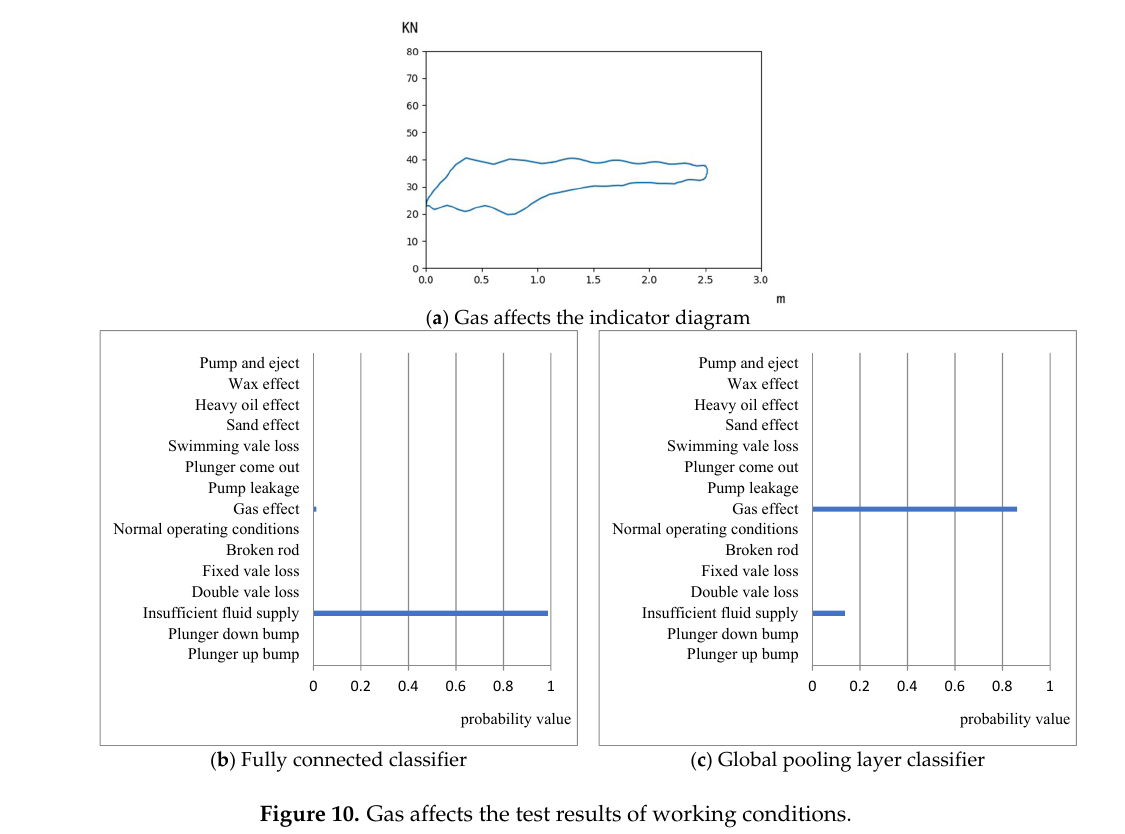
Figure 10. Gas affects the test results of working conditions.